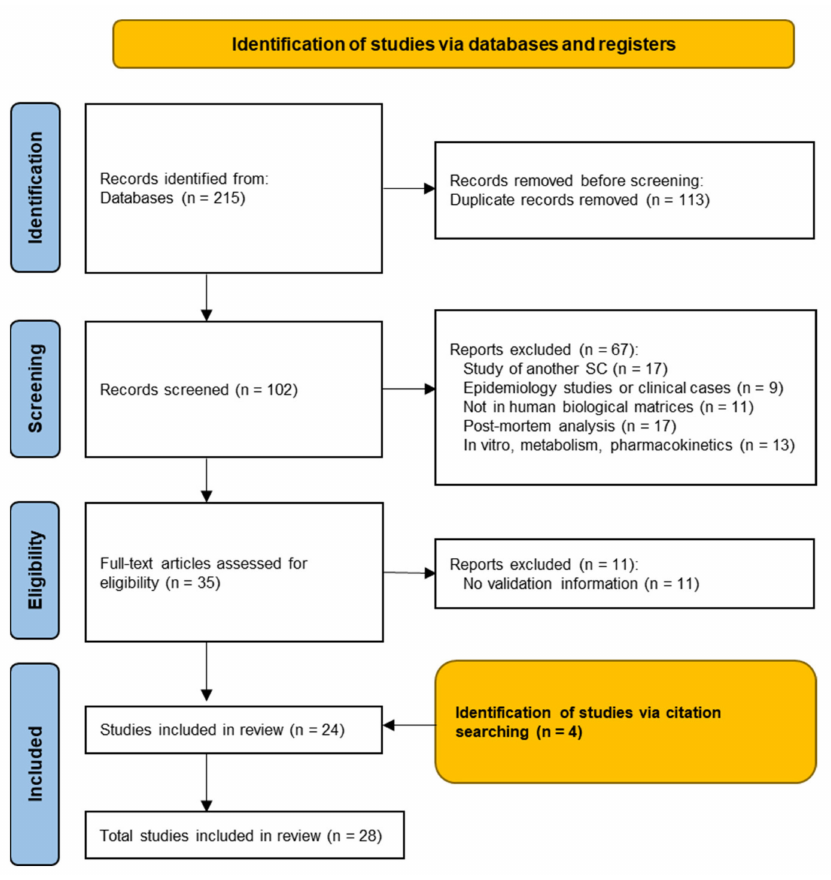
Figure 2. PRISMA flowchart for the selected